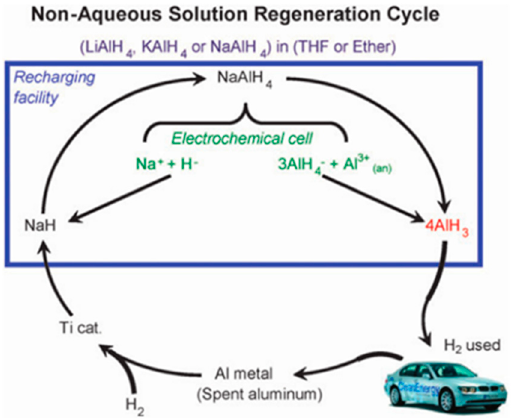
Figure 8. Proposed reversible fuel cycle for alane. Reprinted with permission from Ref. [56]. Copy- right 2021 Elsevier.